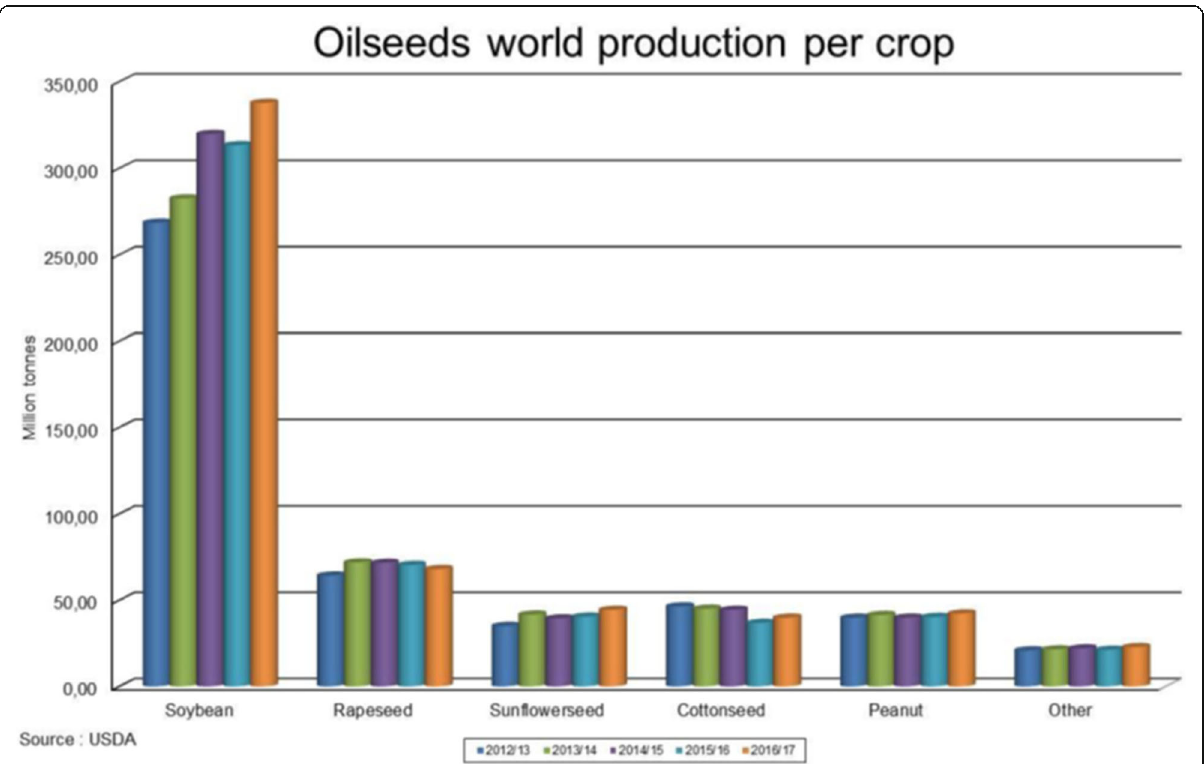
Fig. 2 Oilseed world production per crop over the years from 2012 to 2016. [Source: USDA (European Commission,